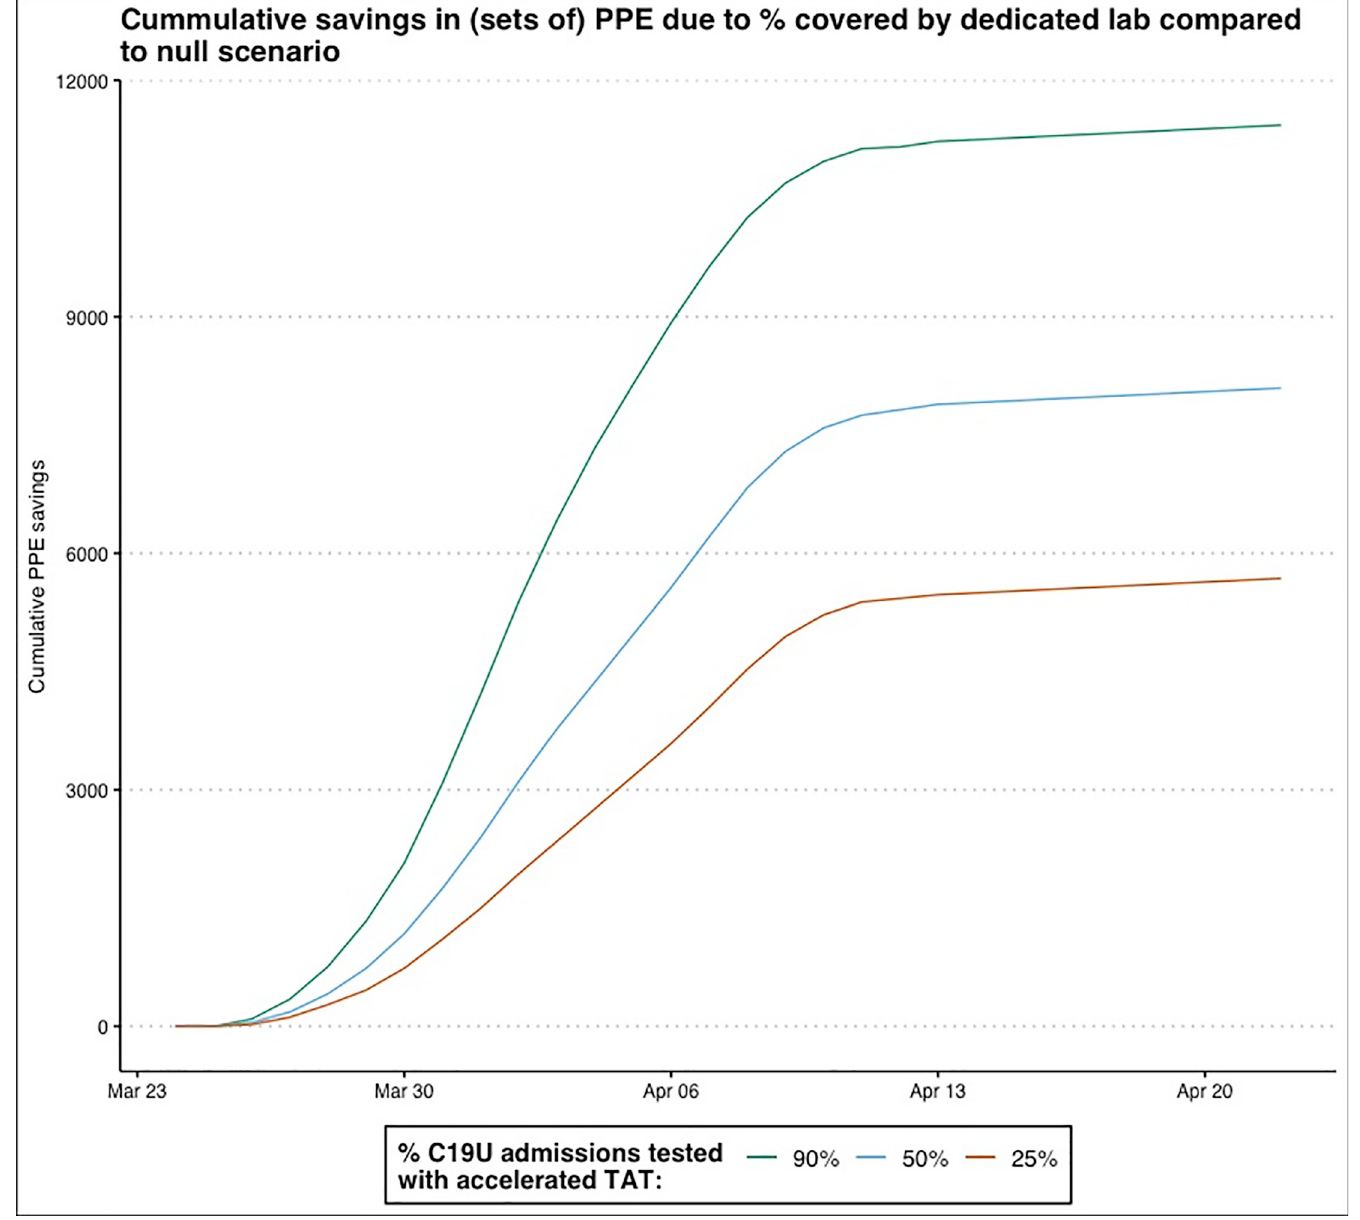
Fig 3. Cumulative simulated savings in PPE at 25% (red line), 50% (blue line), or 90% (green line) accelerated TATs compared to baseline of 0% accelerated TATs.